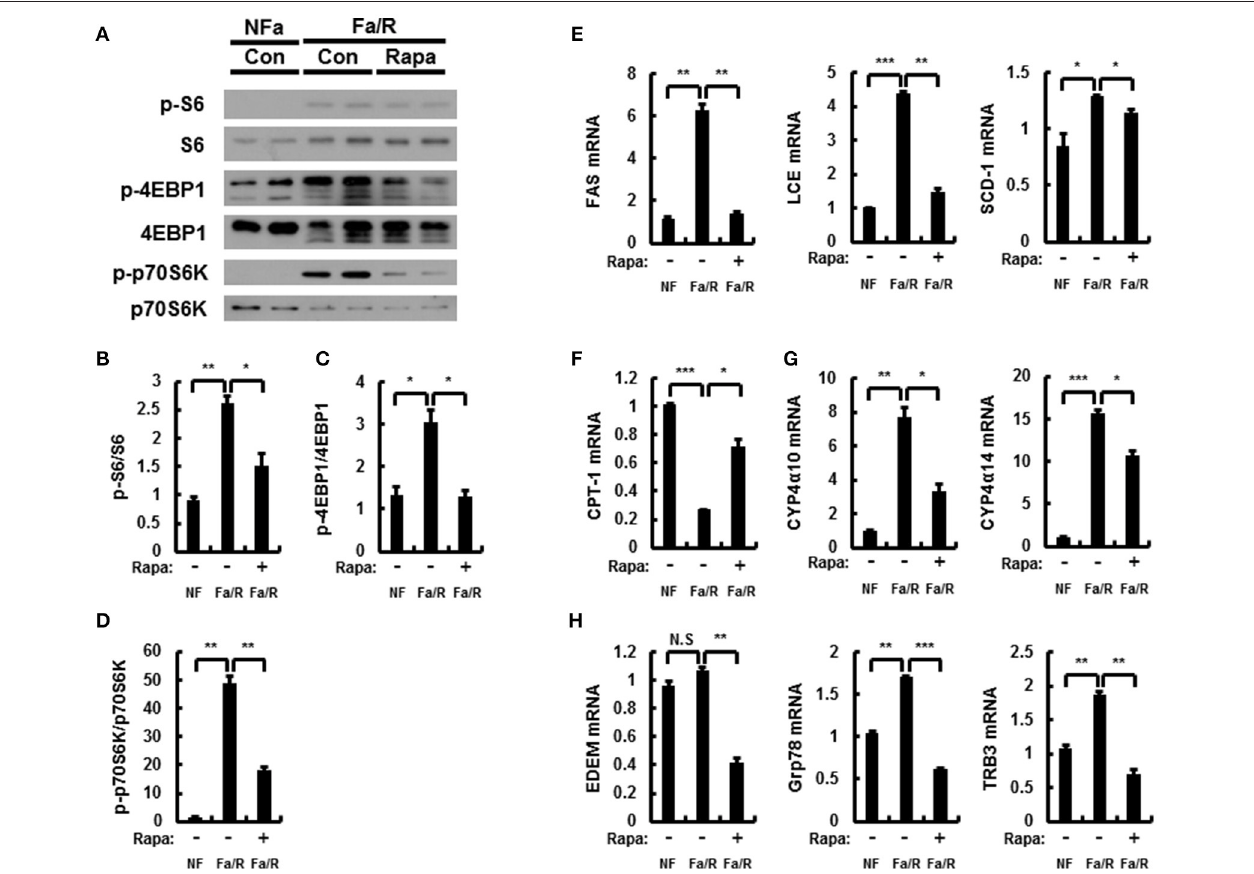
FIGURE 5 | Rapamycin inhibits acute lipogenesis-induced oxidative stress in liver. (A–H) Mice were maintained in a non-fasted state (NFa) ( n = 4) or fasted overnight and then refed a high-carbohydrate, fat-free diet (Fa/R) with vehicle ( n = 4) or rapamycin ( n = 4). (A) The livers from eight or nine mice of each group were pooled and homogenized; subsequently, the homogenates were subjected to immunoblotting analysis with antibodies to the indicated proteins. The intensity of protein bands to p-S6/S6 (B) , p-4EBP1/4EBP1 (C) , and p-p70S6K/p70S6K (D) in (A) was determined by densitometry. (E–H) The total RNA isolated from liver was subjected to qRT-PCR analysis. FAS, SCD-1, and LCE mRNAs (E) , CPT-1 mRNA (F) , Cyp4 α 10, and Cyp4 α 14 mRNAs (G) , and EDEM, Grp78, and TRB3 mRNAs (H) . The data are presented relative to the corresponding value for non-fasted mice. The data in (B–H) are presented relative to the corresponding value for non-fasted mice and are the mean ± standard error for eight or nine mice in each group. * p < 0.05, ** p < 0.01, and *** p <